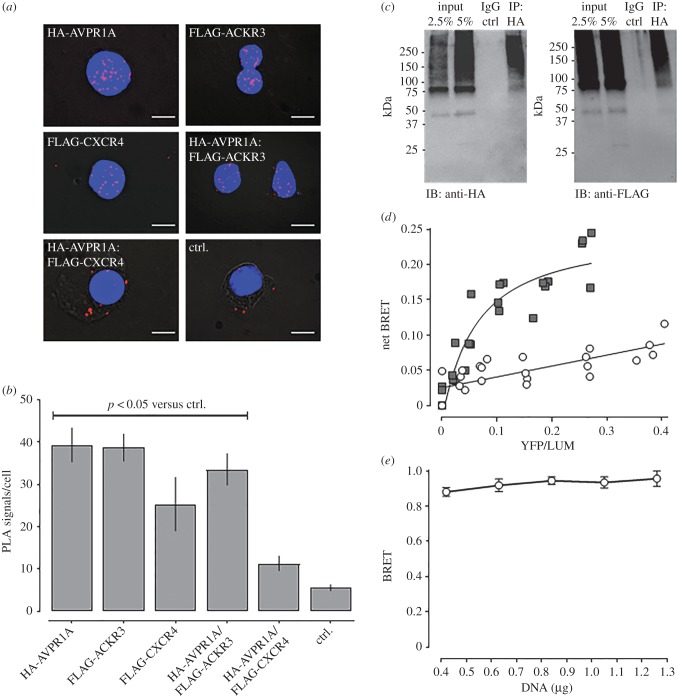
Recombinant ACKR3 and AVPR1A form heteromeric complexes. (a) Typical PLA images for the detection of individual receptors and receptor–receptor interactions in HEK293T cells transfected with DNA encoding HA- or FLAG-tagged receptors. Ctrl: cells transfected with pcDNA. Images show merged PLA/DAPI signals acquired from z-stack images (n = 10; thickness 1 µm, bottom to top). Scale bars, 10 µm. (b) Quantification of PLA signals per cell as in (a). n = 3 independent experiments with n = 10 images per condition and experiment. (c) HEK293T cells expressing HA-AVPR1A and FLAG-ACKR3 were lysed (input), the lysate was immunoprecipitated (IP) with anti-HA, followed by immunoblotting (IB) to detect HA-AVPR1A (left) and FLAG-ACKR3 (right) in the IP samples. IP control: precipitate after incubation of cell lysates with IgG-coupled resin. (d,e) Intermolecular BRET assays. Cells were co-transfected with AVPR1A-hRluc plus EYFP (open circles) or ACKR3-EYFP (grey squares) at various acceptor : donor ratios (d) and with increasing amounts of AVPR1A-hRluc and ACKR3-EYFP at a constant ratio of 1 : 10 (e).